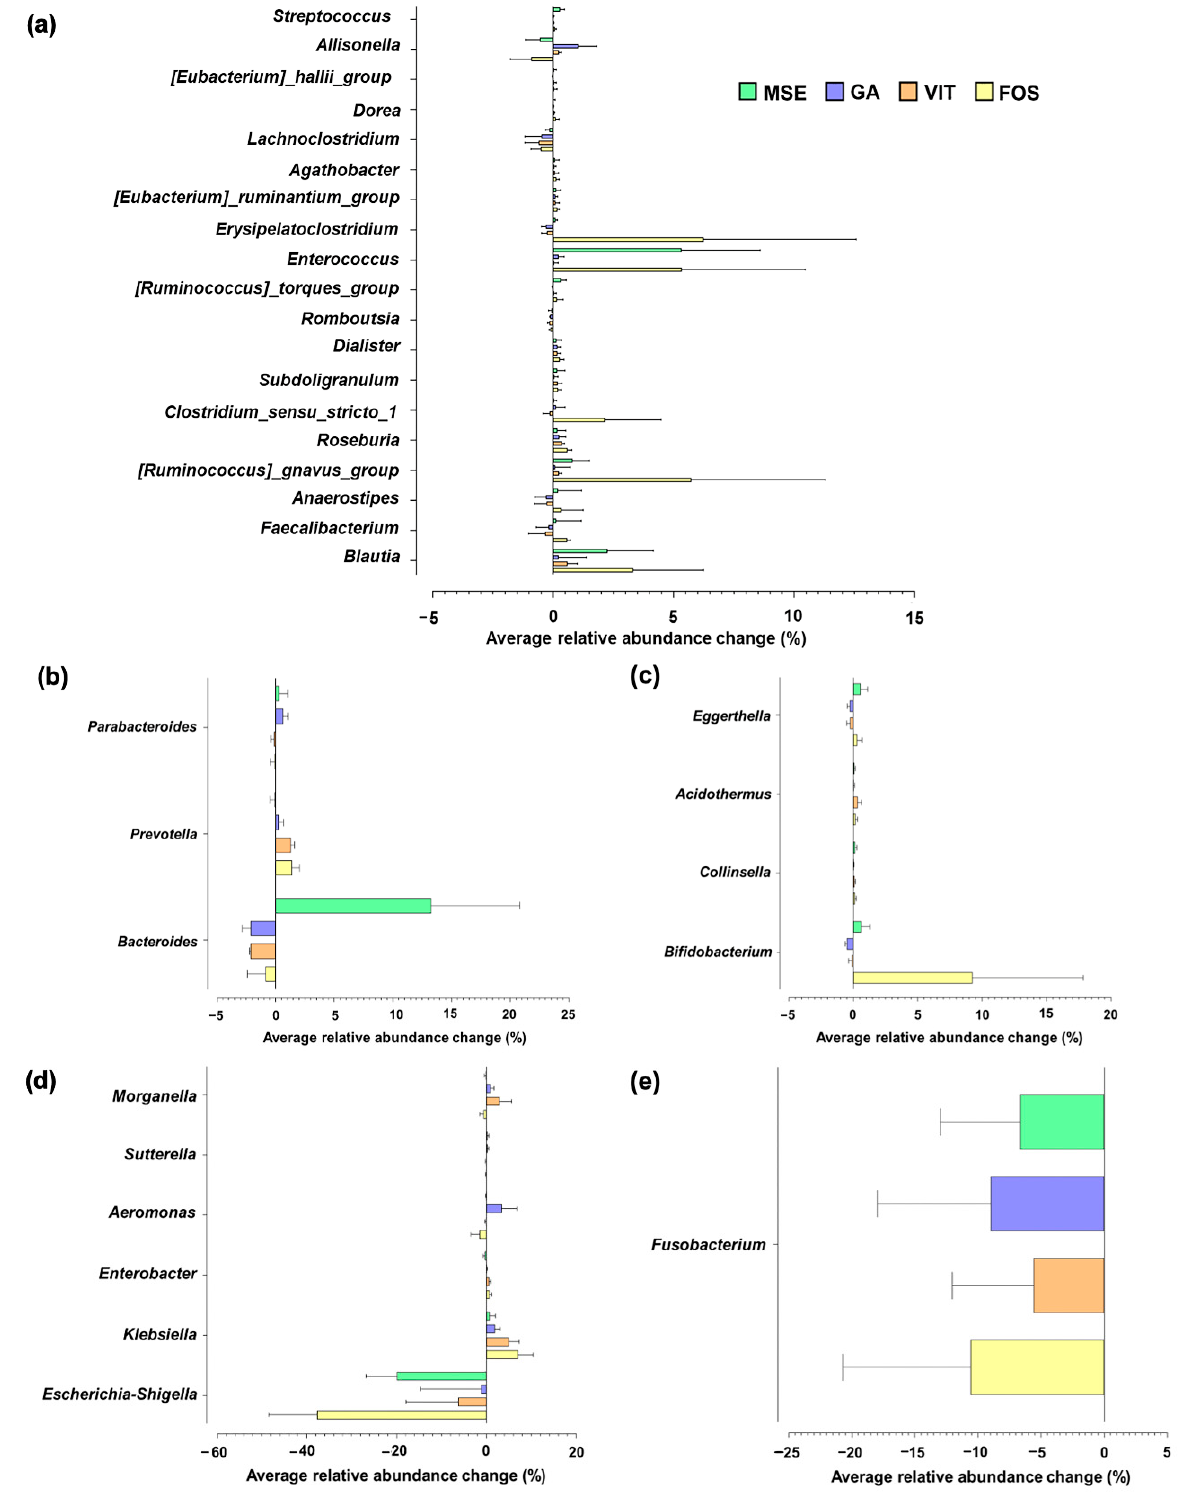
Figure 3. Genus-level changes in the gut microbiota of fermentations with mung bean seed coat extract (MSE), gallic acid (GA), vitexin (VIT), and fructo-oligosaccharide (FOS), compared with the microbiota of fermentation without added substrate (control; CON), following 24 h of fecal fermen- tation. Only taxa with relative abundances higher than 0.15% were included. Each taxon was grouped based on its phylum level: ( a ) Firmicutes, ( b ) Bacteroidota, ( c ) Actinobacteriota, ( d ) Proteobacteria, and ( e )